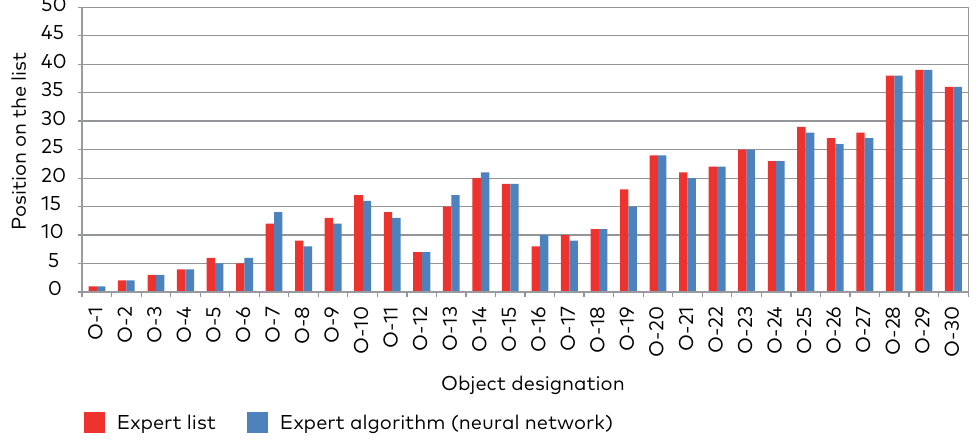
Figure 5. Comparison of a position in the expert list and the list created by the expert algorithm